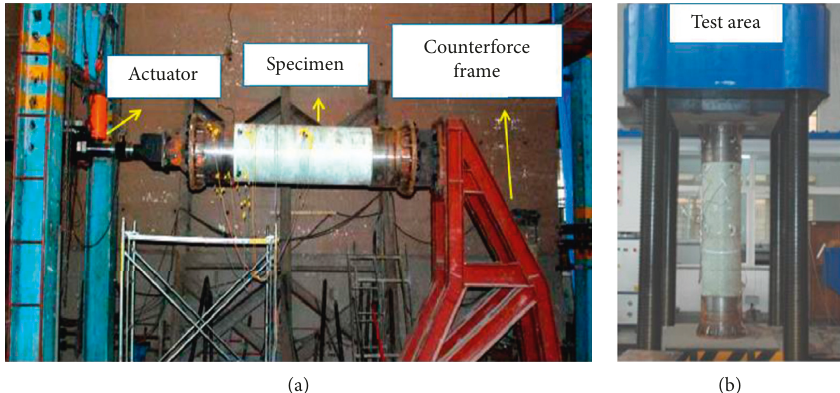
Figure 2: Test devices: (a) high-cycle fatigue test; (b) ultimate bearing capacity test.